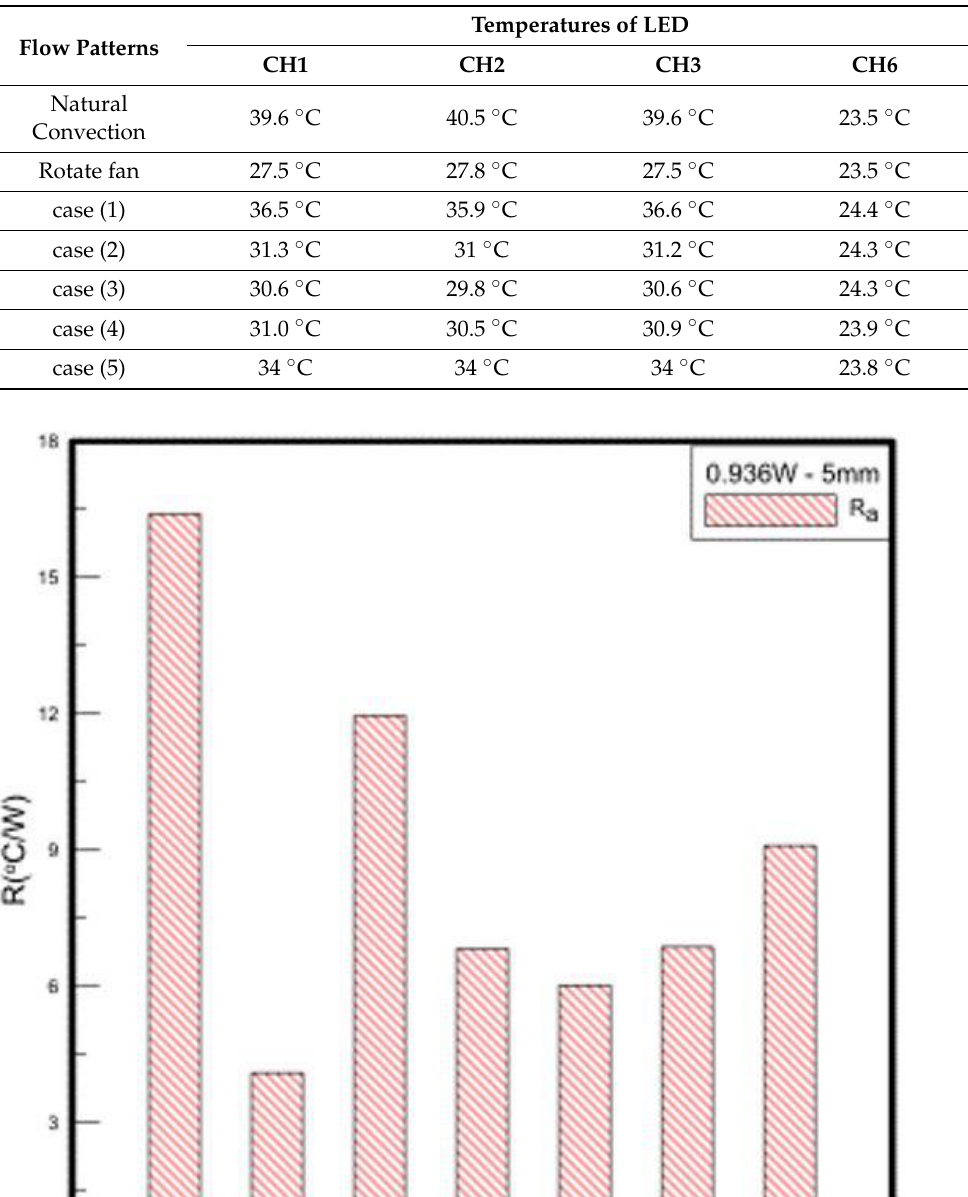
Table 3. Temperatures of LED for free and forced convection under 1 W and 5 mm.